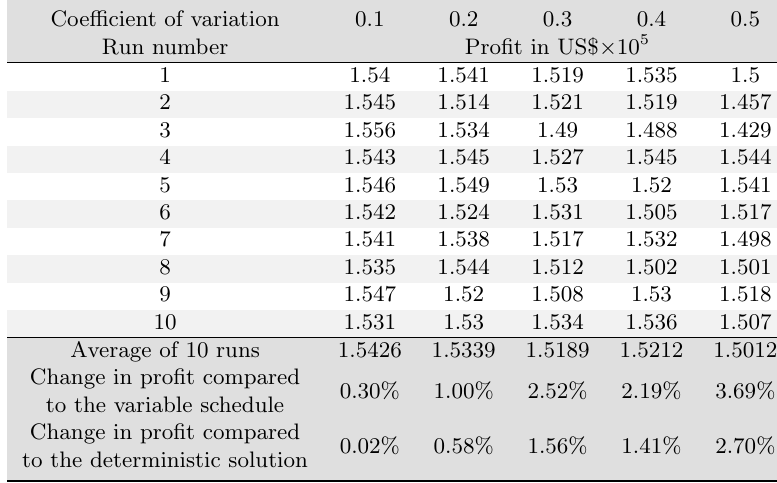
Table 14: Profit from fixed schedule and random catch of IFPMXL ( t ) .